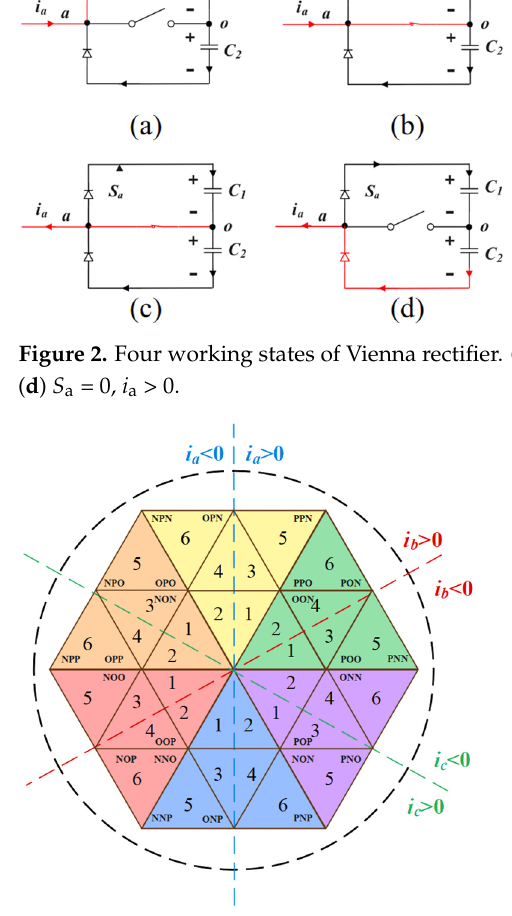
Figure 3. Space vector diagram of Vienna rectifier.